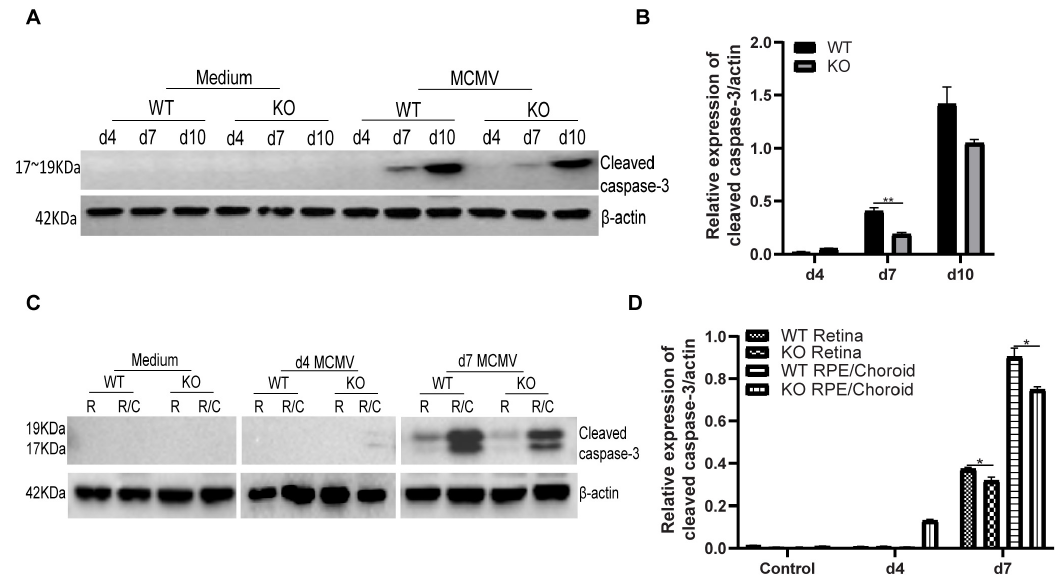
Figure 5. ( A , B ) Western blot of cleaved caspase-3 in medium-injected or MCMV-injected eyes of WT or KO mice at day 4, 7, and 10 p.i. ( A ); ratio of cleaved caspase-3 to β -actin ( B ). ( C , D ). Western blot of cleaved caspase-3 in the retinas or posterior eyecups (R/C) isolated from medium-injected (control) or MCMV-injected eyes of WT or KO mice at day 4 and 7 p.i. ( C ); ratio of cleaved caspase-3 to β -actin ( D ). Data are shown as mean ± SEM ( n = 3). * p < 0.05, ** p < 0.01 by 2-tailed t -test.